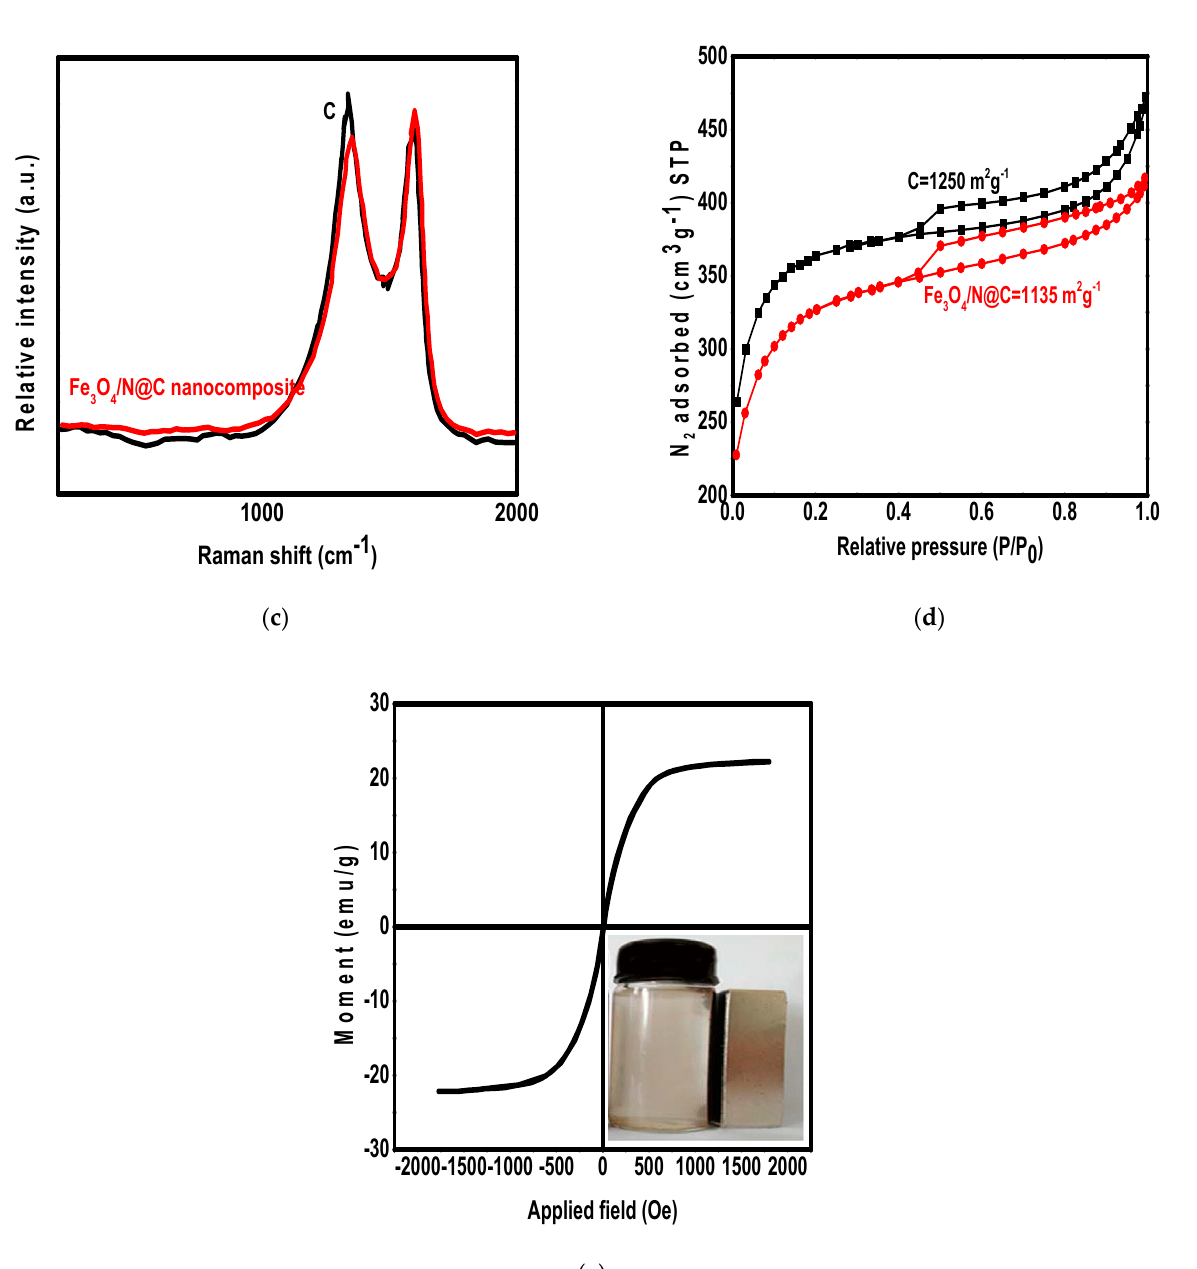
Figure 2. FT-IR ( a ), XRD ( b ), Raman shift ( c ), N 2 adsorption isotherms ( d ) of rice husk carbon and Fe 3 O 4 /N@C nanocom- posite, and magnetization curve of Fe 3 O 4 /N@C nanocomposite ( e ) (inset: the magnetic separation of the nanocomposite using an external magnet after Pb 2+ adsorption).